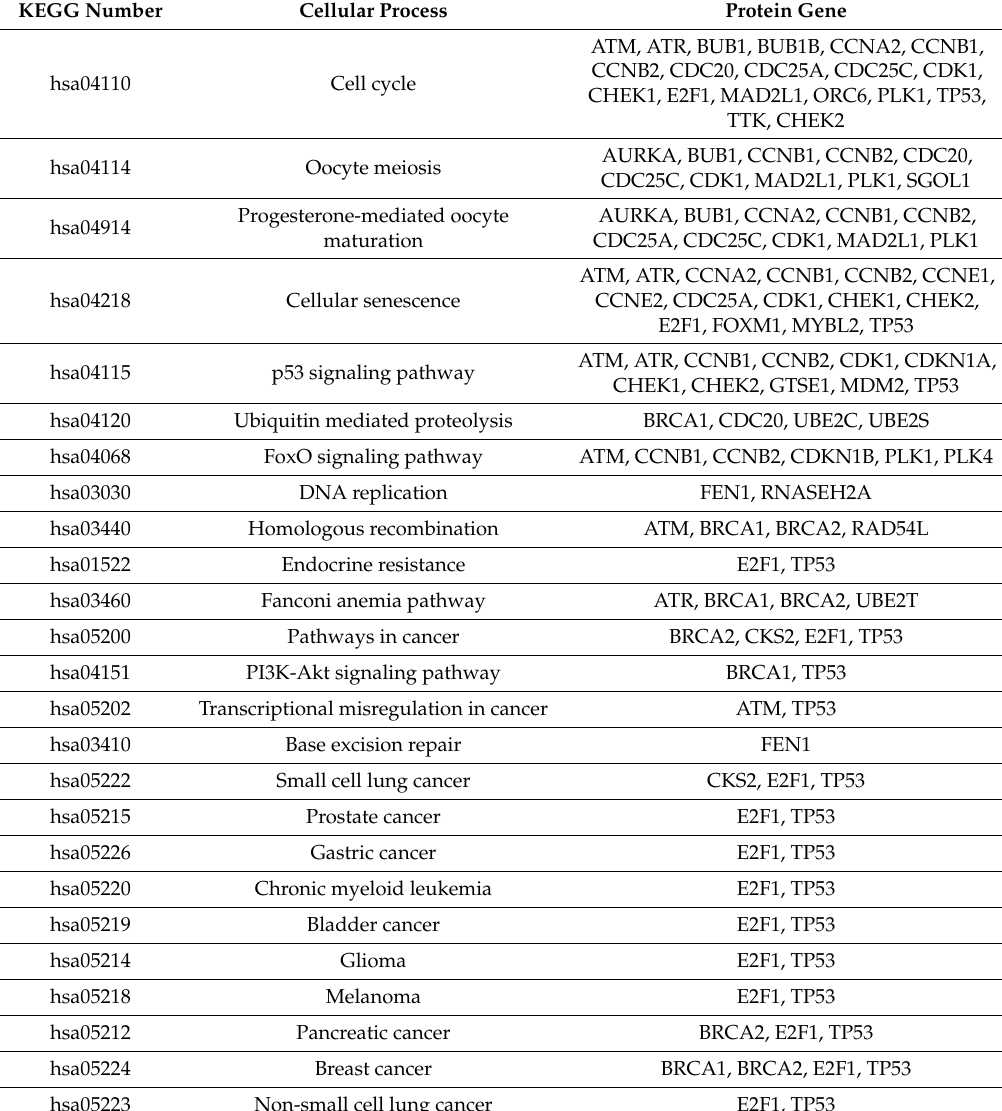
Table 4. Biological pathways related to proteins involved in UBE2C